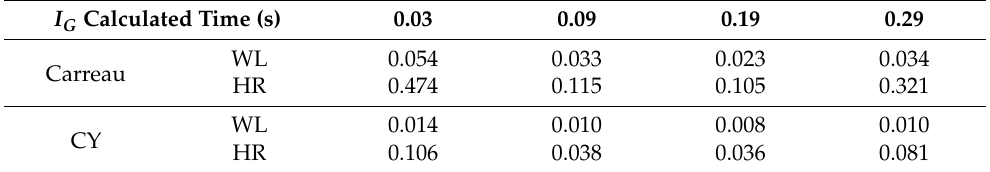
Table 2. I G at four time